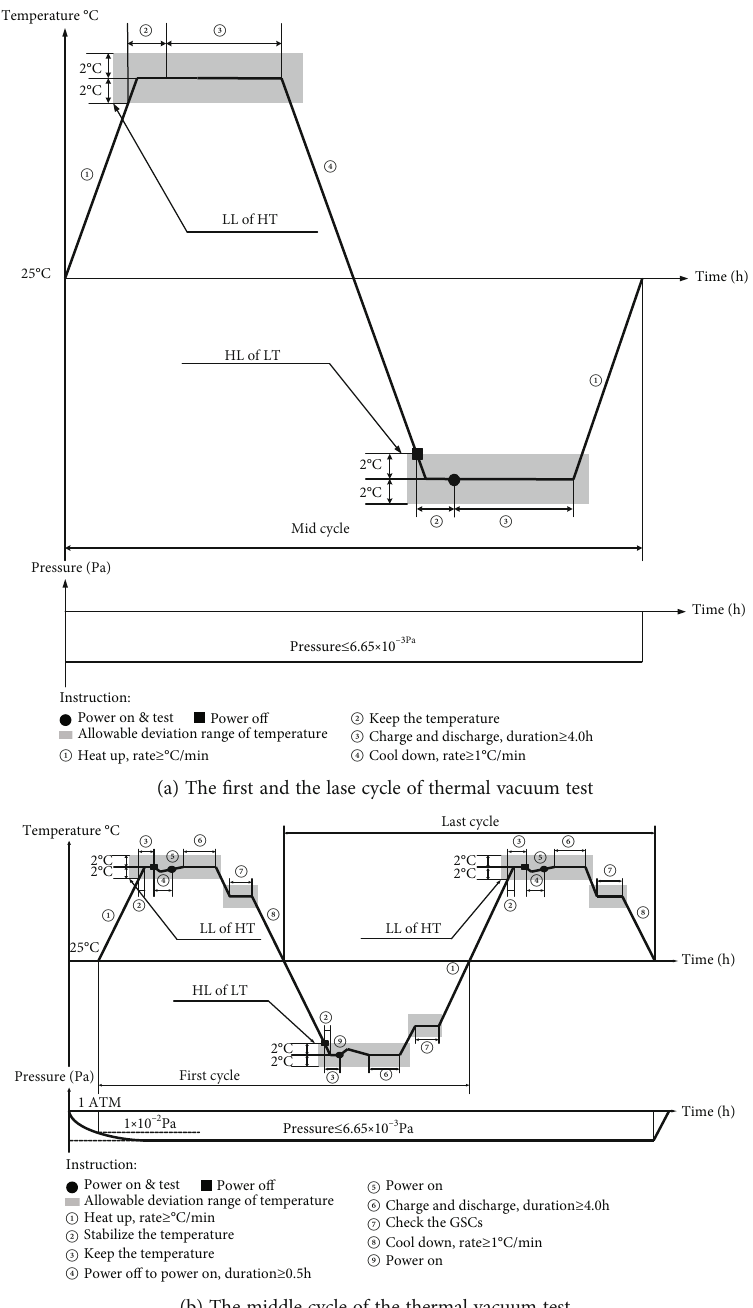
Figure 12: Temperature curve of thermal vacuum